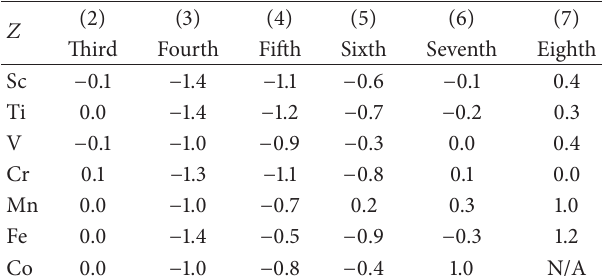
Table 8: Percentage difference between values shown in Tables 6 and 7.